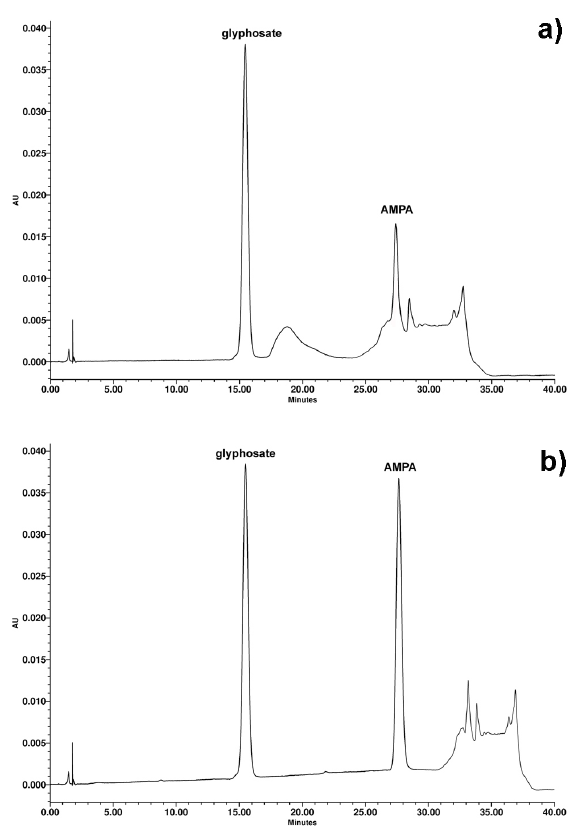
Figure 2: LC-FLD chromatograms of glyphosate and AMPA for rape spike at 0.5 mg kg -1 (a) without clean-up and (b) after SPE C18